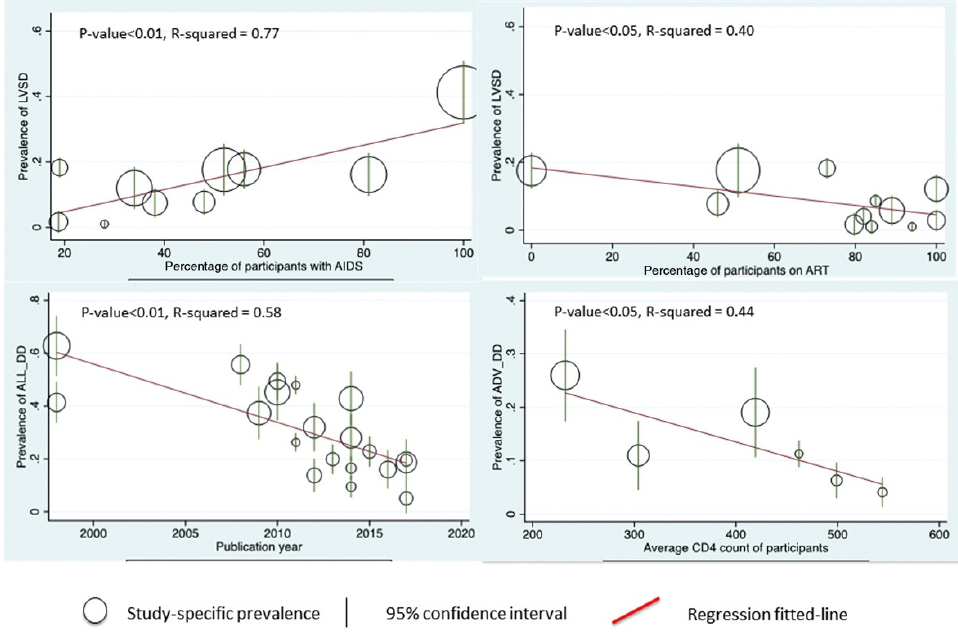
Figure 2. Meta-regression analysis of left ventricular systolic dysfunction (LVSD) and diastolic